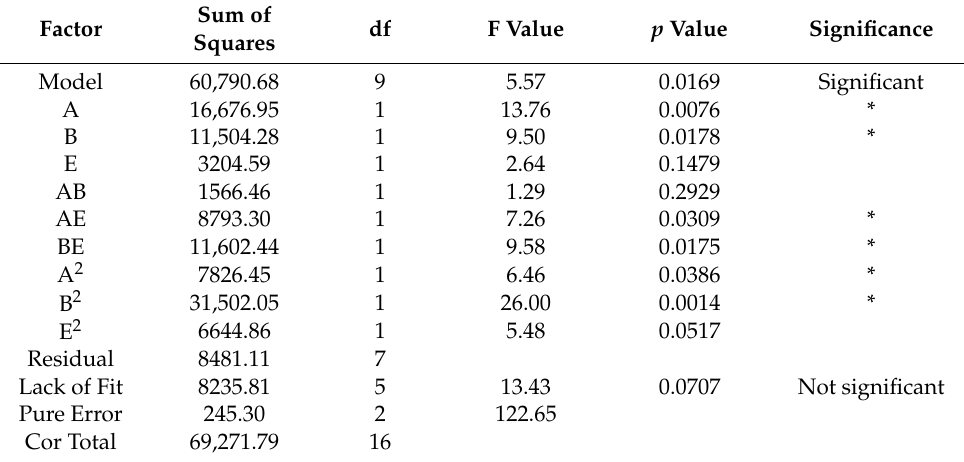
Table 10. Regression coefficients and their significance for response surface quadratic